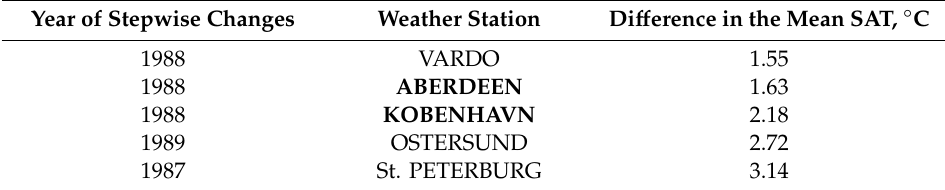
Table 5. Assessment of the warming in Northern Europe based on the divided trends (1951–2016 period, February). The weather stations with the bold font are those with ∆ step ≥ 10%.